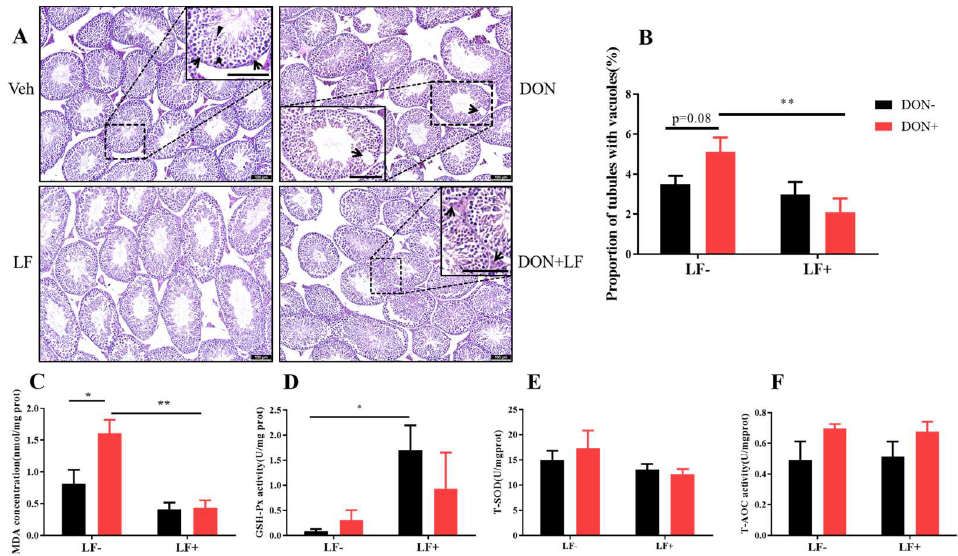
Figure 2. Effects of dietary DON and oral administration of LF on testis histological and oxidative status. ( A ) Testis histological, arrows point to Sertoli cells and the bold arrowhead indicates spermatids and well-developed spermatids with tail extended into the seminiferous tubule matrix (triangle) was observed (enlarged section in Veh); the arrow indicated vacuoles embedded in the epithelium (enlarged section in DON); arrows pointed to Leydig cells in the interstitial tissue of the testis (enlarged section in DON + LF). ( B ) The proportion of tubules with vacuoles. Testicular MDA concentration ( C ), GSH-Px activity ( D ), T-SOD activity ( E ) and T-AOC activity ( F ). Data were presented as mean ± SEM. For one-way ANOVA, * p < 0.05 and ** p < 0.01.